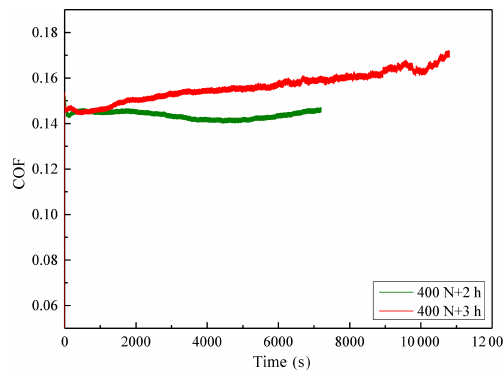
Figure 11. Profile curve of the wear surface under different loads.